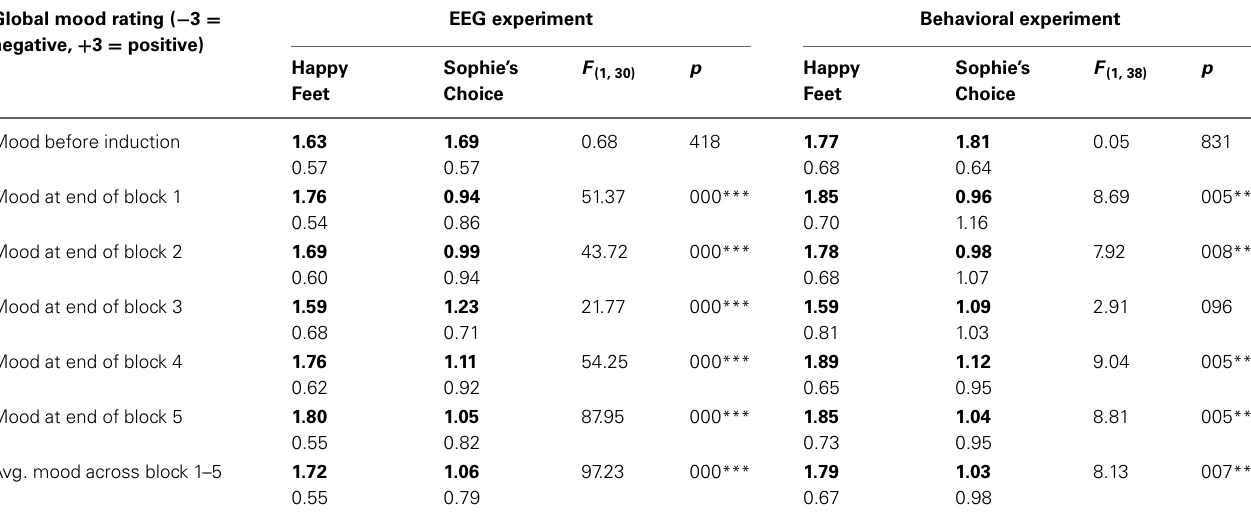
Table 2 | Self-reported mood score means (bold) and standard deviations (regular) before and during the EEG experiment (left) or the behavioral post-test (right), on a 7-point aggregated scale ( − 3, maximally negative; 0, neutral; + 3, maximally positive). Global mood rating ( − 3